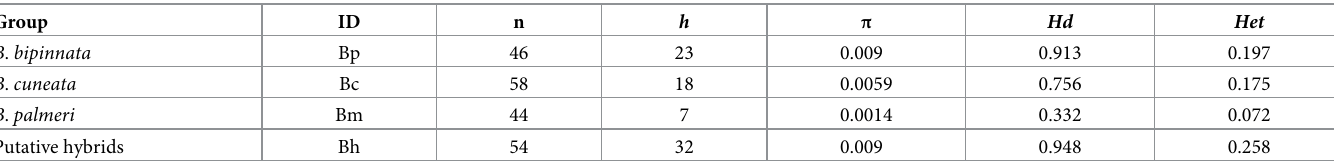
Table 2. Genetic diversity indices of the concatenated ETS and PEPC nuclear genes in three Bursera species and their putative hybrids. Group ID n h π Hd Het B . bipinnata